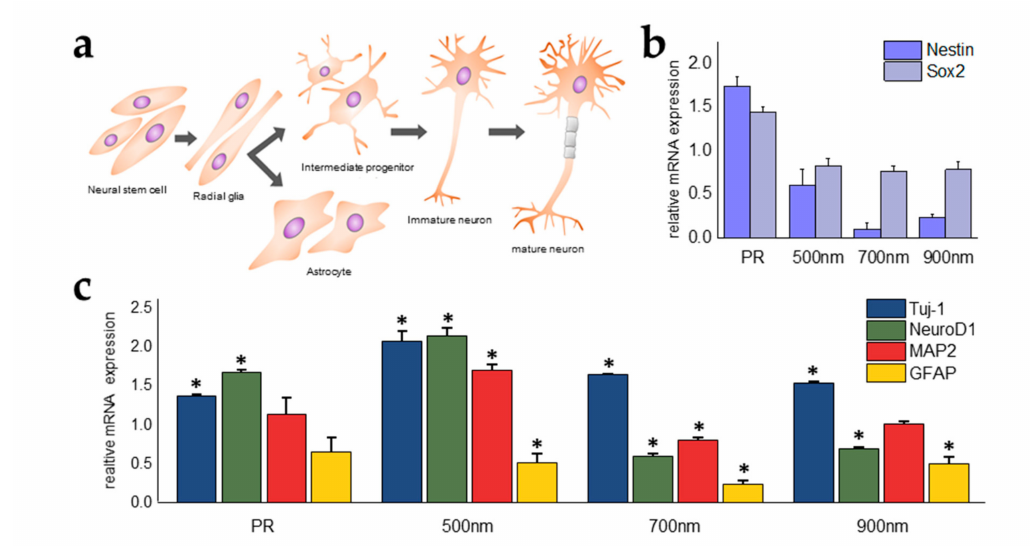
Figure 7. qPCR analysis of neural di ff erentiation of mNSCs ( a ) A schematic diagram representating neural di ff erentiation processes from neural stem cells into di ff erentiated cells (mature neurons or astrocytes). RT-qPCR data for ( b ) undi ff erentiation markers (Nestin and SOX2), ( c ) neuronal markers (TuJ-1, NeuroD1, and MAP2) and glial markers (GFAP). Control = bare ITO substrate; the results were normalized to control group; * p < 0.05, n = 3, unpaired student’s t